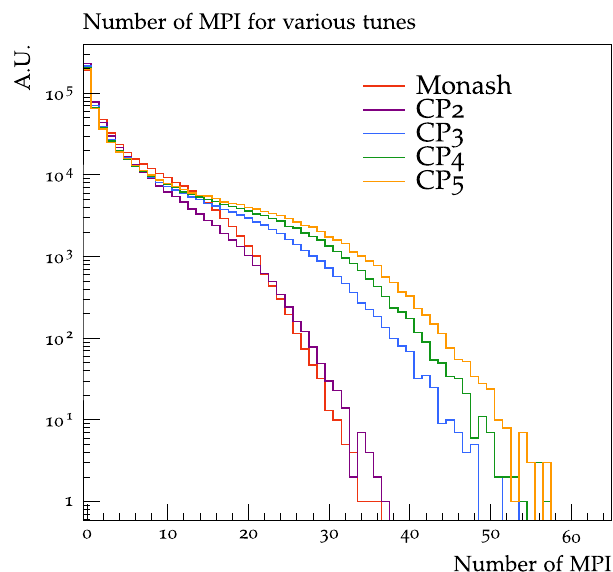
differentversionsoftheNNPDF3.1PDFset:LO,NLO,andNNLO.The ratio of NNPDF3.1 gluon distribution functions to the NNPDF2.3LO gluon distribution function are also